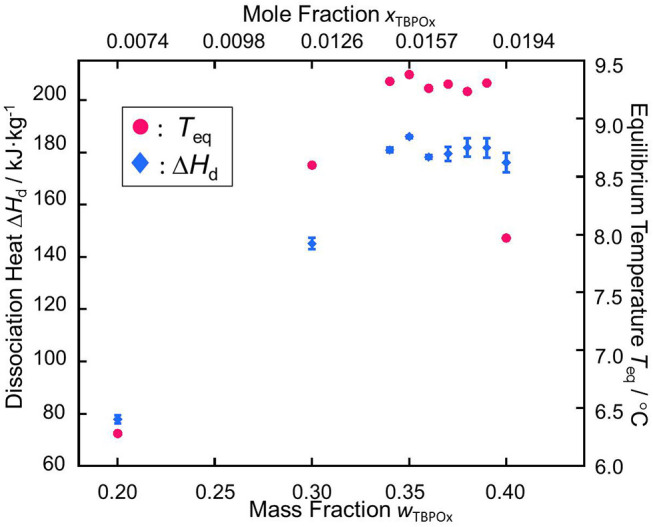
Relationships between the equilibrium temperature Teq and the dissociation heat ΔHd vs. the mass fraction of TBPOx aqueous solution wTBPOx and the mole fraction of TBPOx aqueous solution xTBPOx: red •, the phase equilibrium temperature of TBPOx hydrate; blue ♦, the dissociation heat of TBPOx hydrate.